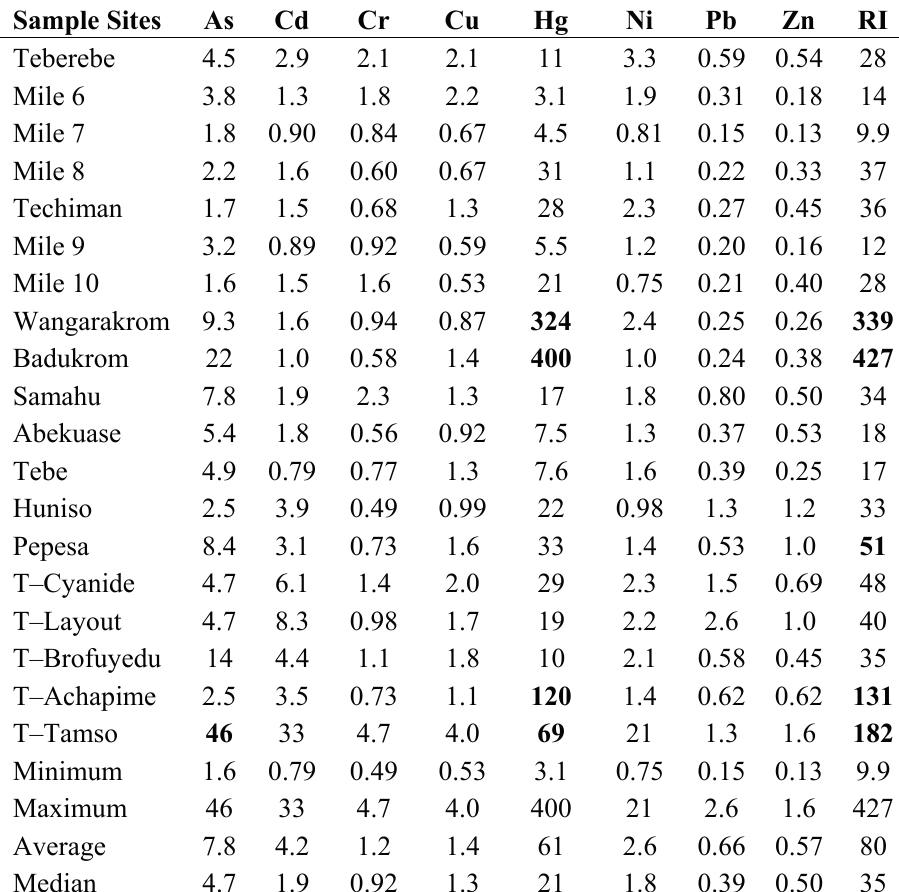
Table 5. E i and RI of heavy metals and a metalloid in surface soils in Tarkwa. r Sample